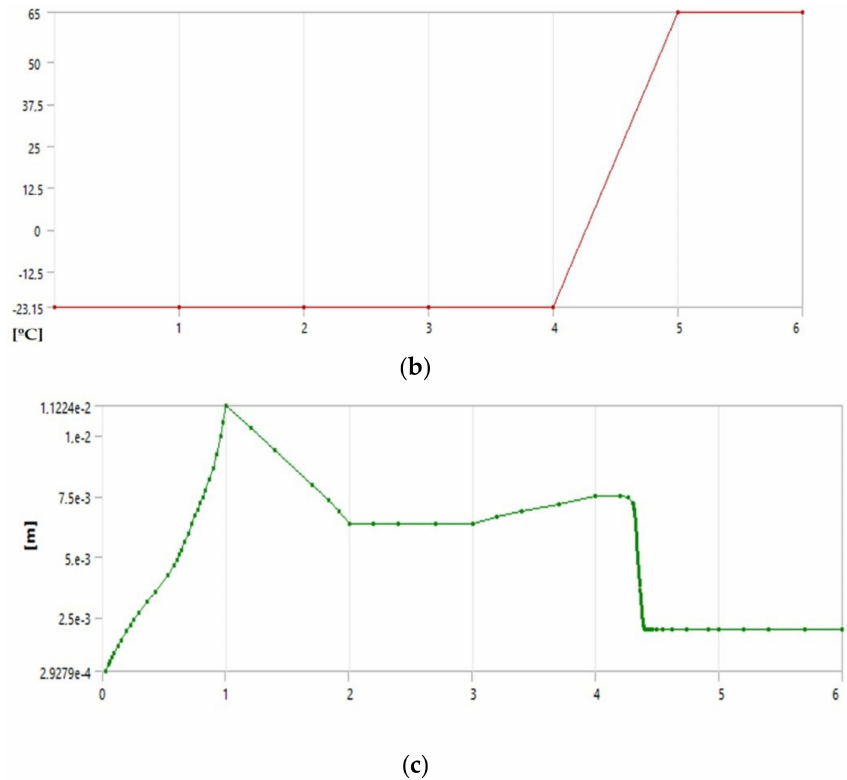
Figure 6. SMA spring analysis. ( a ) force applied for each step, ( b ) thermal conditions applied for each step, ( c ) total deformation for each step.